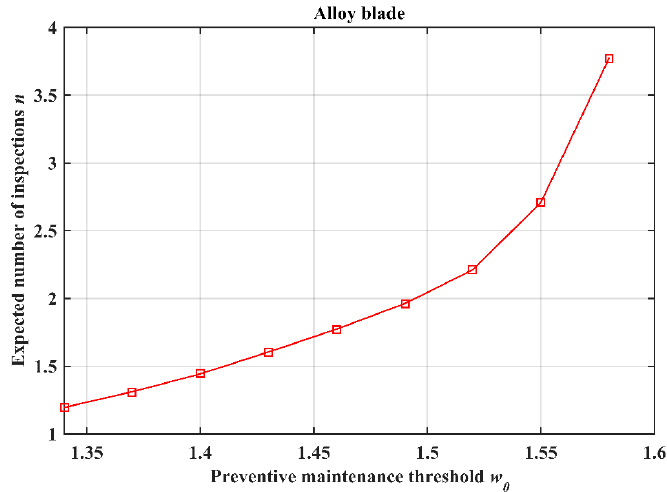
Figure 13. Total expected number of inspections versus the PM threshold w 0 at q = 0.95 .